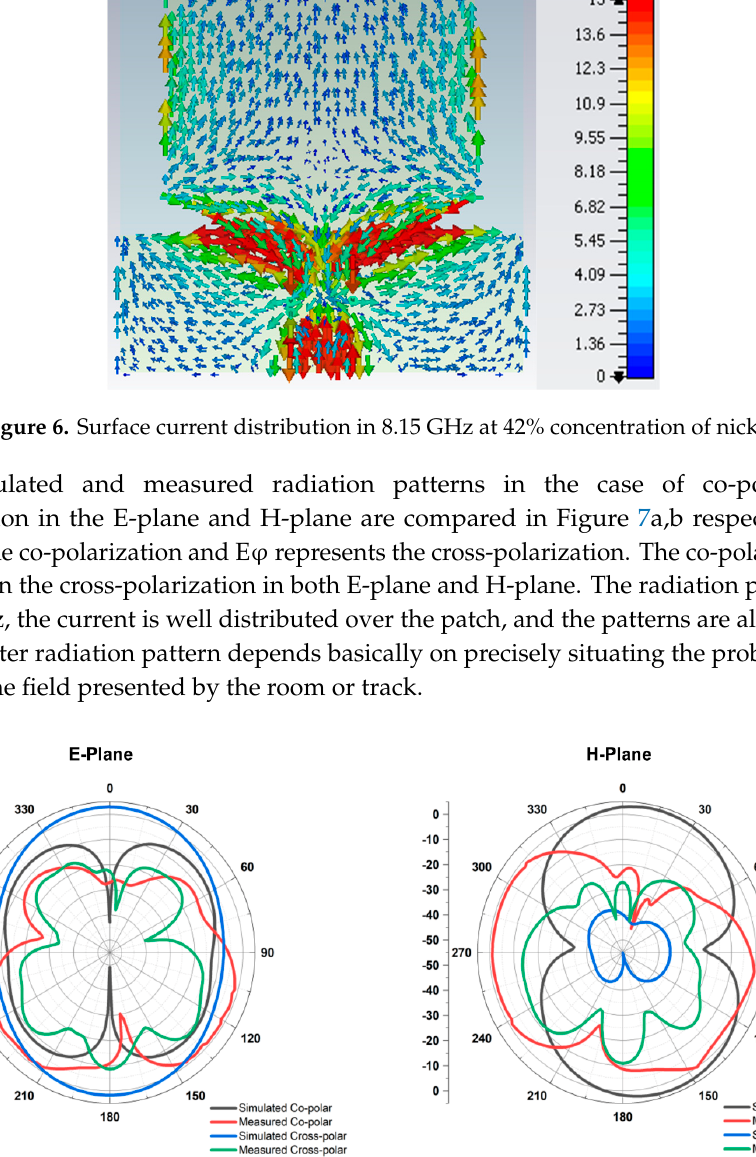
Figure 5. Measured and simulated, ( a ) gain and ( b ) total efficiency of the designed flexible antenna; at 42% concentration of nickel.